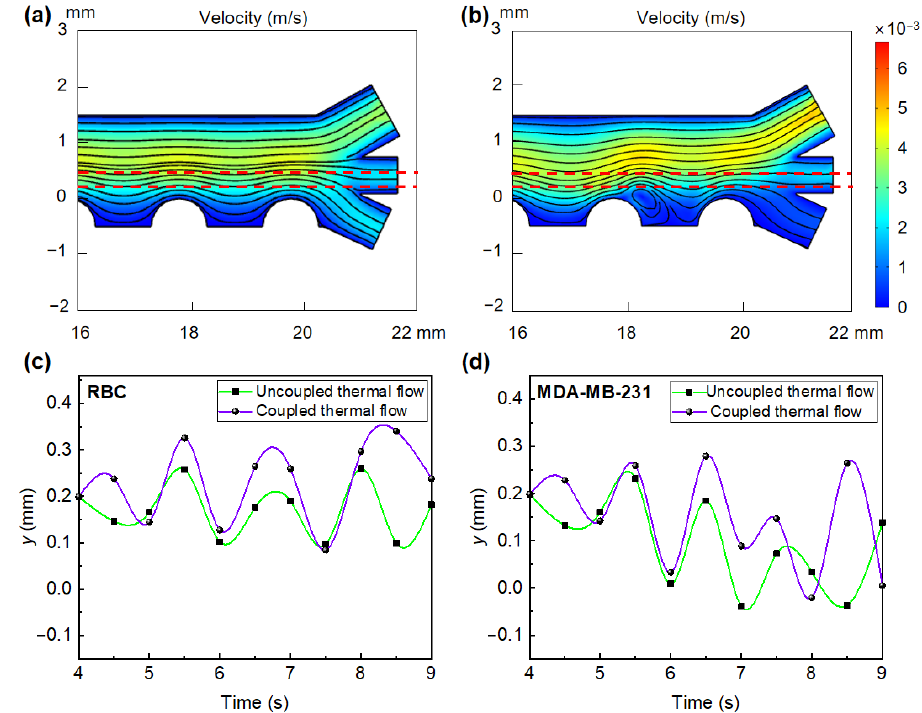
Figure 8. The influence of heat flow induced by Joule heating on cell separation process at U 0 = 60 V eff (electrode array design 2): ( a ) Fluid flow in an uncoupled thermal field; ( b ) fluid flow in a coupled thermal field; height difference of ( c ) RBCs and ( d ) MDA-MB-231 in the separation channel with coupled/uncoupled thermal effect.